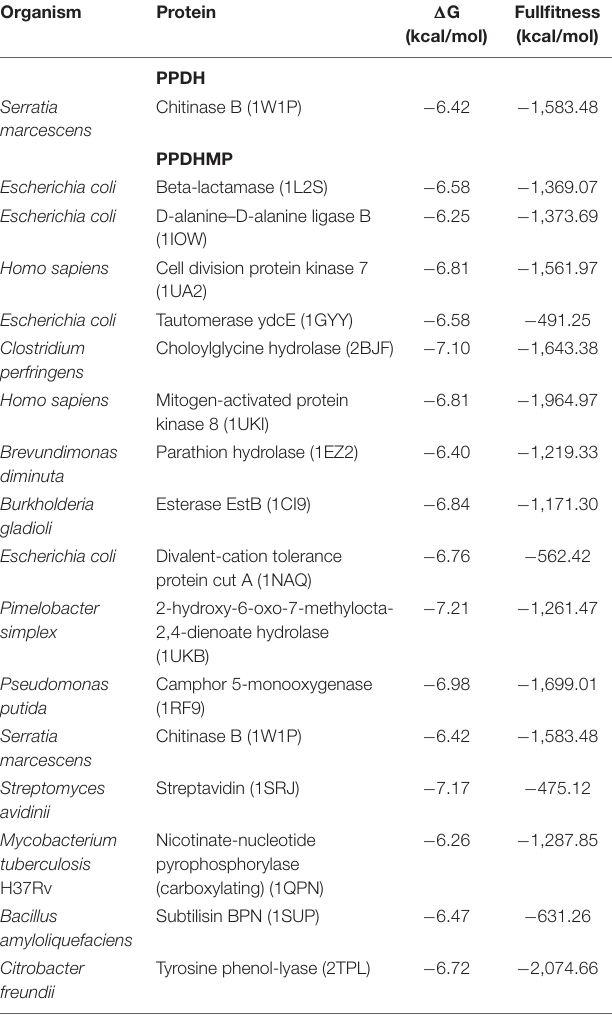
TABLE 2 | Docking analysis of PPDH and PPDHMP with its likely